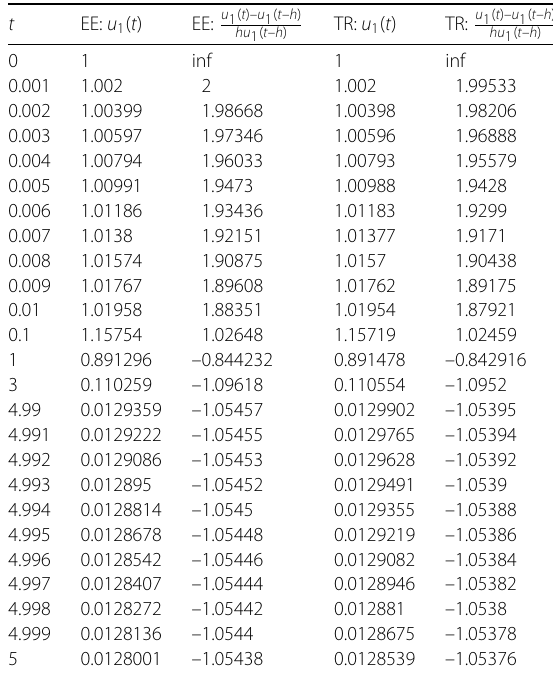
Table 3 Poincaré-type differential equation: Computation of u 1 ( t ) for p =